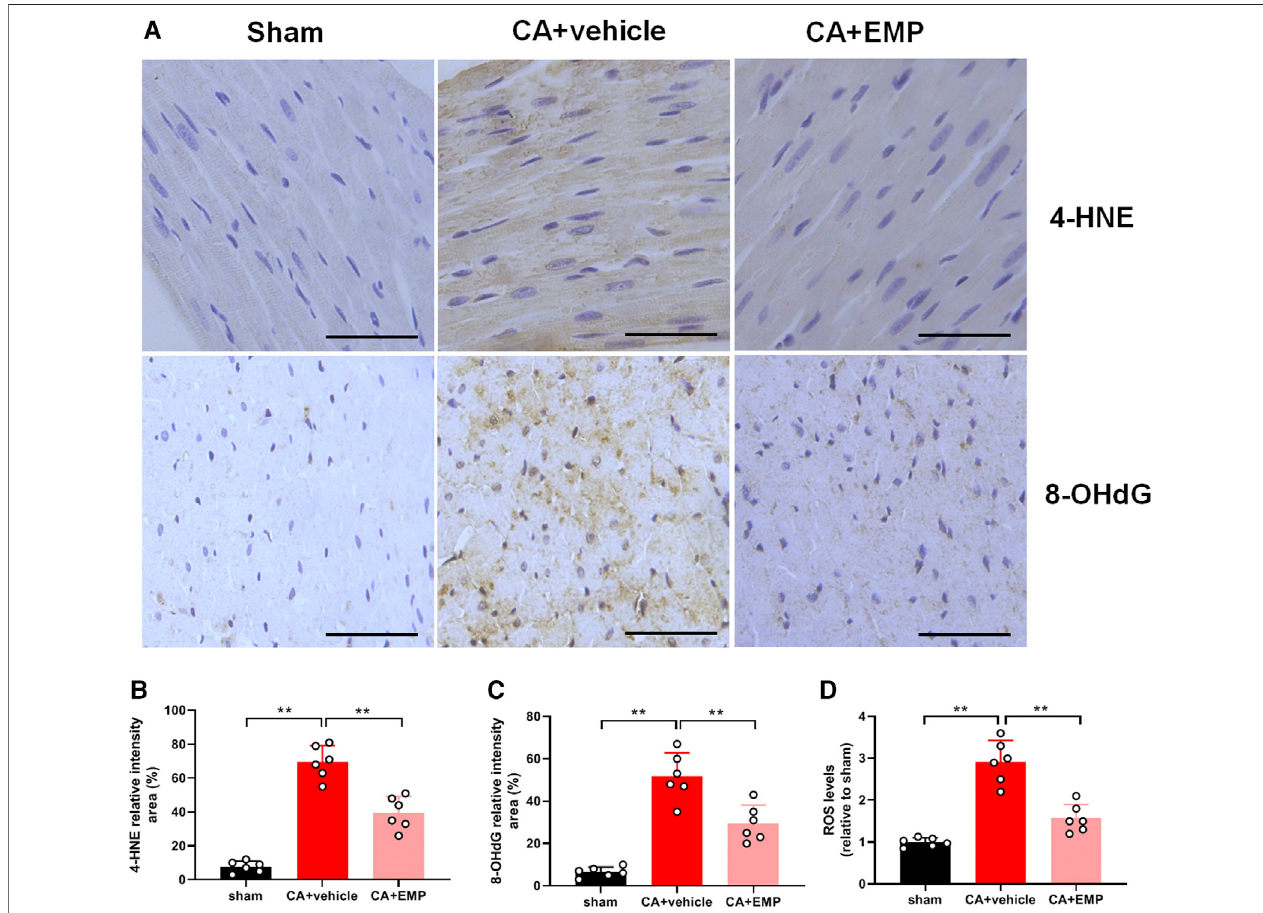
FIGURE 4 | Empagli fl ozin (EMP) decreased myocardial oxidative stress after cardiac arrest in rats. (A) Representative photographs of 4-hydroxynonenal (4-HNE) and 8-hydroxy-2 ′ -deoxyguanosine (8-OHdG) immunostaining of heart sections obtained 24 h after return of spontaneous circulation (ROSC). Scale bar (cid:1) 50 μ m. (B) Quanti fi cation of 4-HNE staining levels from stained heart sections. (C) Quanti fi cation of 8-OHdG staining levels from stained heart sections. (D) The relative reactive oxygen species (ROS) levels in heart tissues obtained 24 h ROSC. Data are presented as mean ± SD, n (cid:1) 6, * p < 0.05, ** p < 0.01.